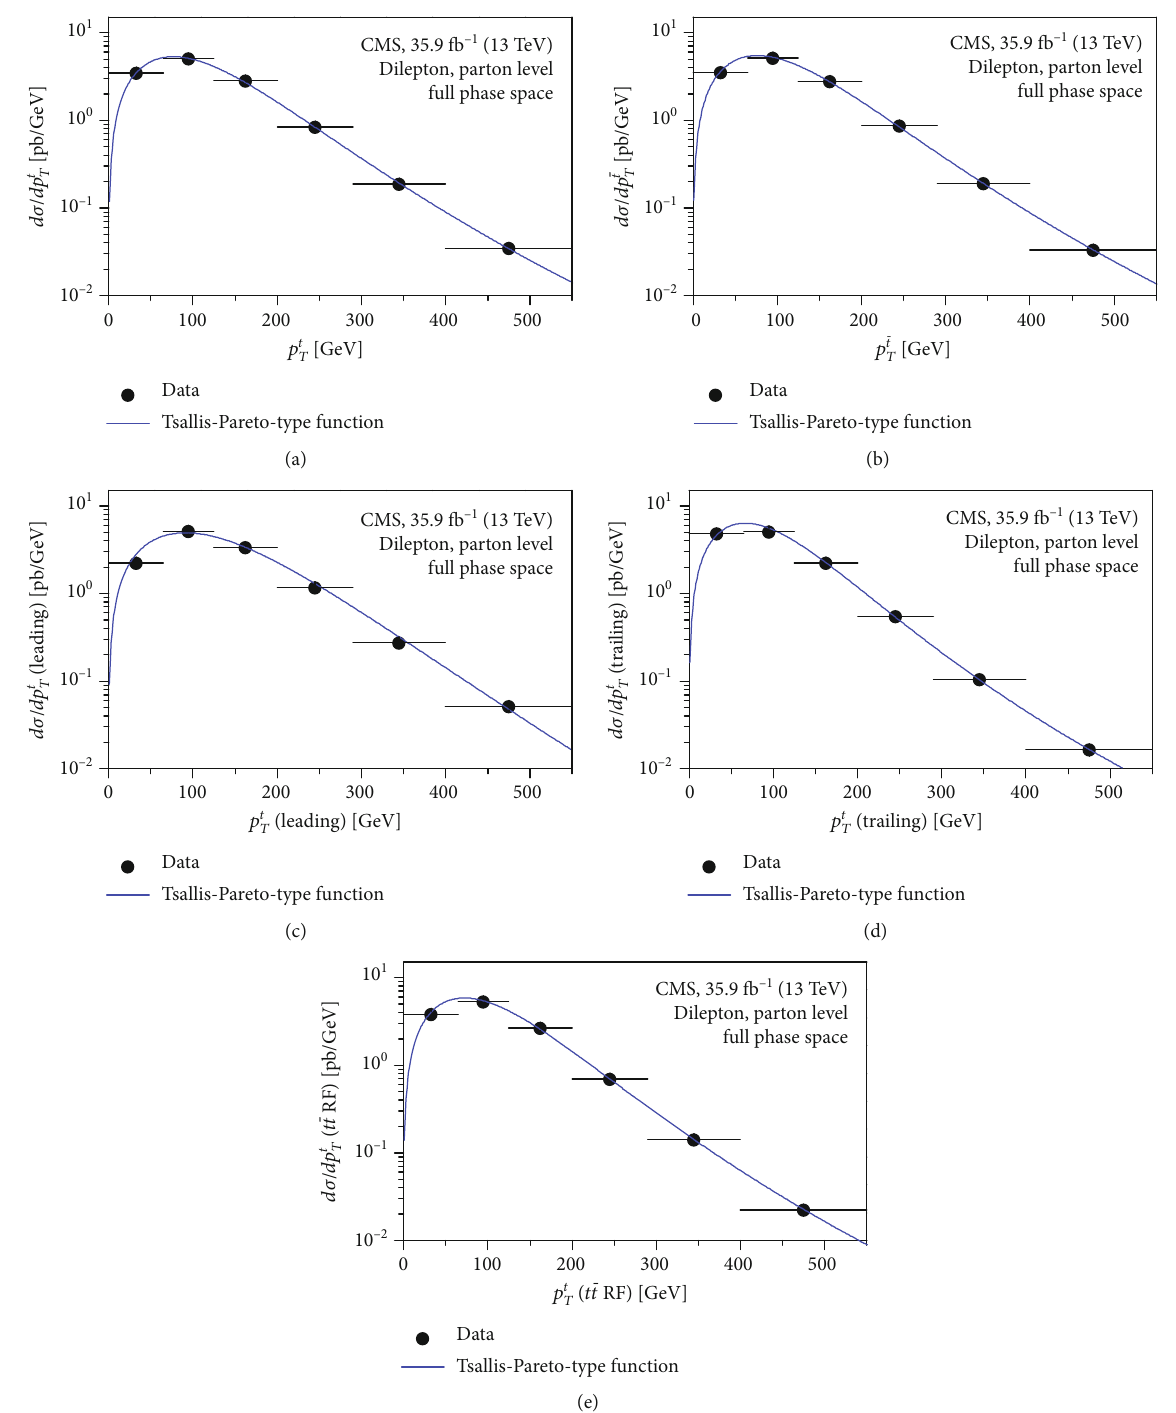
p (cid:1) t T ), (b) the top antiquark ( T ), (c) the top quark or top antiquark with the ffiffi p s = 13 TeV. The solid circles represent the